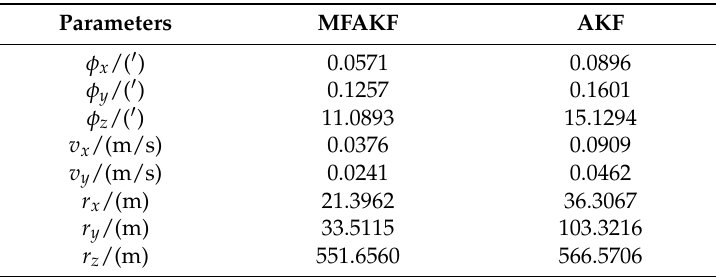
Table 2. RMS errors of SODINS in the experiment.